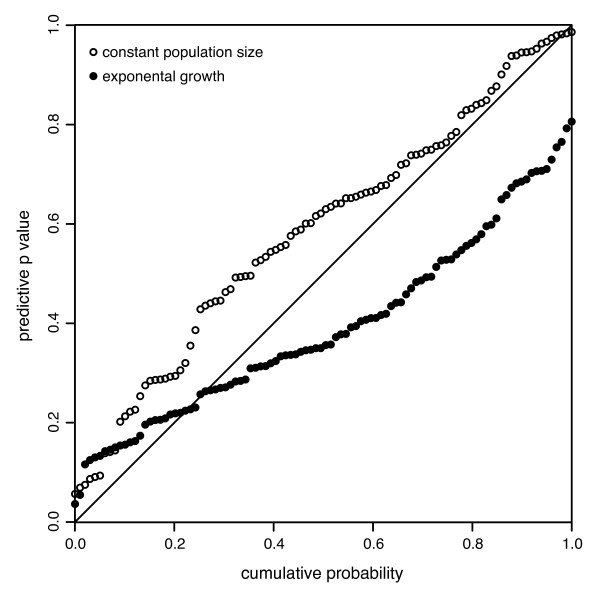
Cumulative distribution of pB. (Cumulative distribution of pB values (based on DF statistic) on 100 simulated data sets under a constant population (open circles) and an exponentially growing population (closed circles). The ideal behaviour for pB when applied to data simulated from the null distribution would be a uniform distribution (see main text for details). This plot shows that if the true demographic history is a constant population, then pB will be a good test of neutrality. However, if the true demographic history is exponential growth pB will be a conservative test, as can be seen by the lack of high pB values in the closed circles.